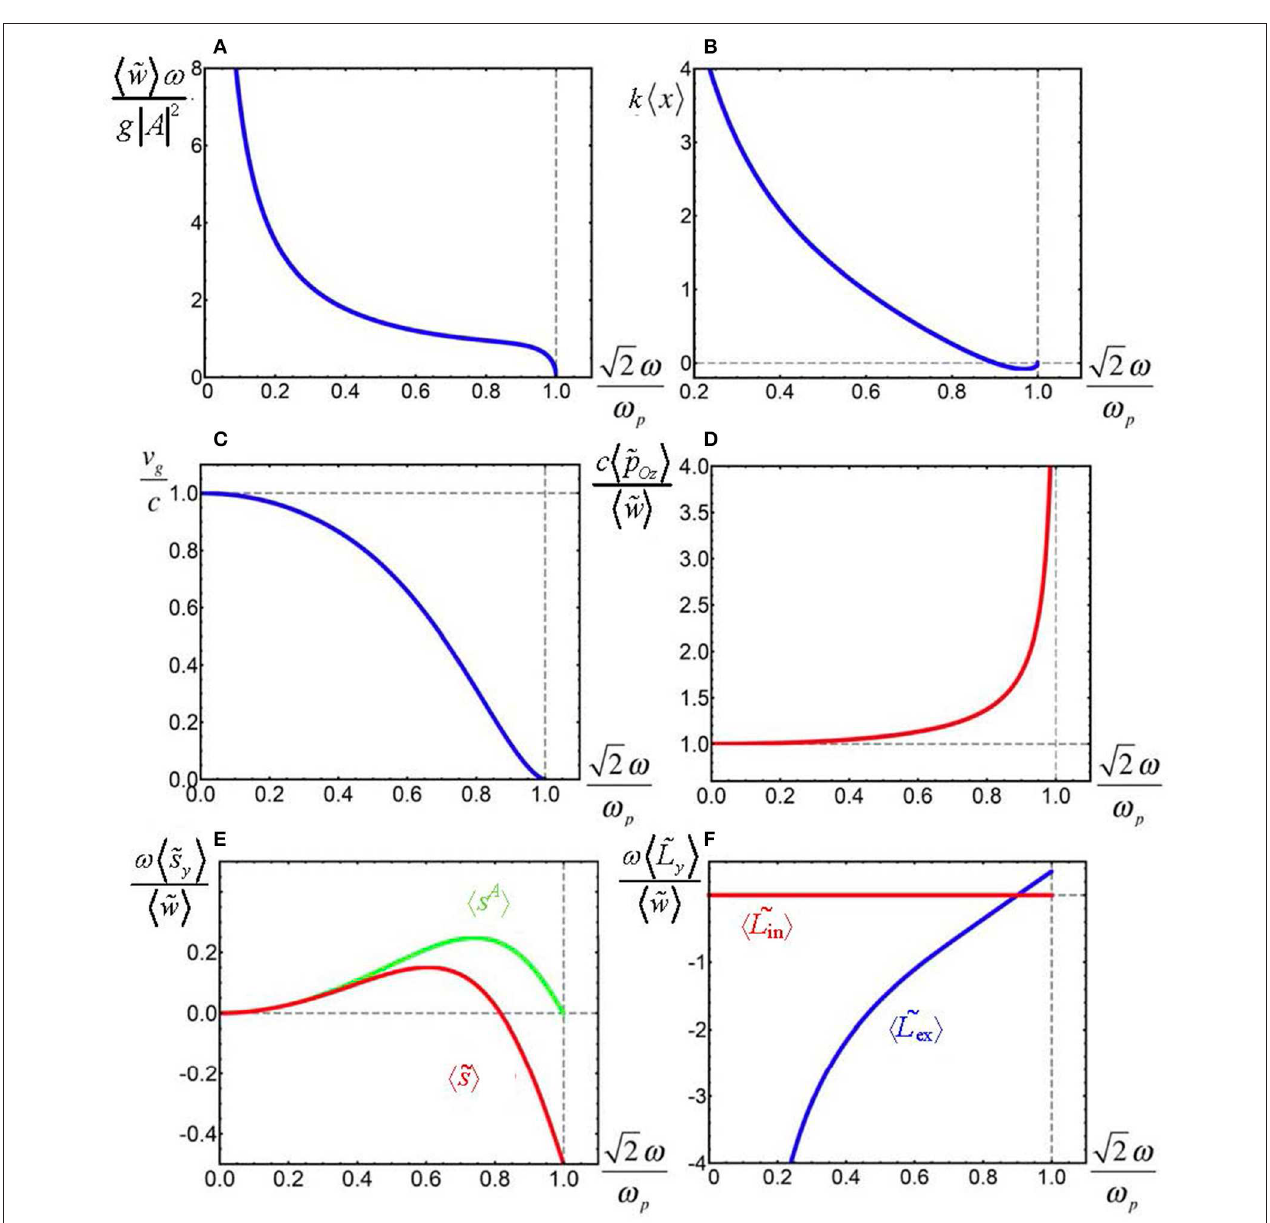
FIGURE 8 | Frequency dependence of the main dynamical characteristic (DC) of the TM SPP wave (70), (71) for the electric and magnetic parameters of media 1 and 2 described by Equation (73) [52, 81]. (A) Integral energy (74); (B) center-of-gravity position (76); (C) group velocity (75); (D) orbital momentum (77); (E) SAM (79) (red line) and the “traditional” Abraham-type spin calculated without the dispersion corrections [53]; (F) intrinsic and extrinsic (with respect to the interface x